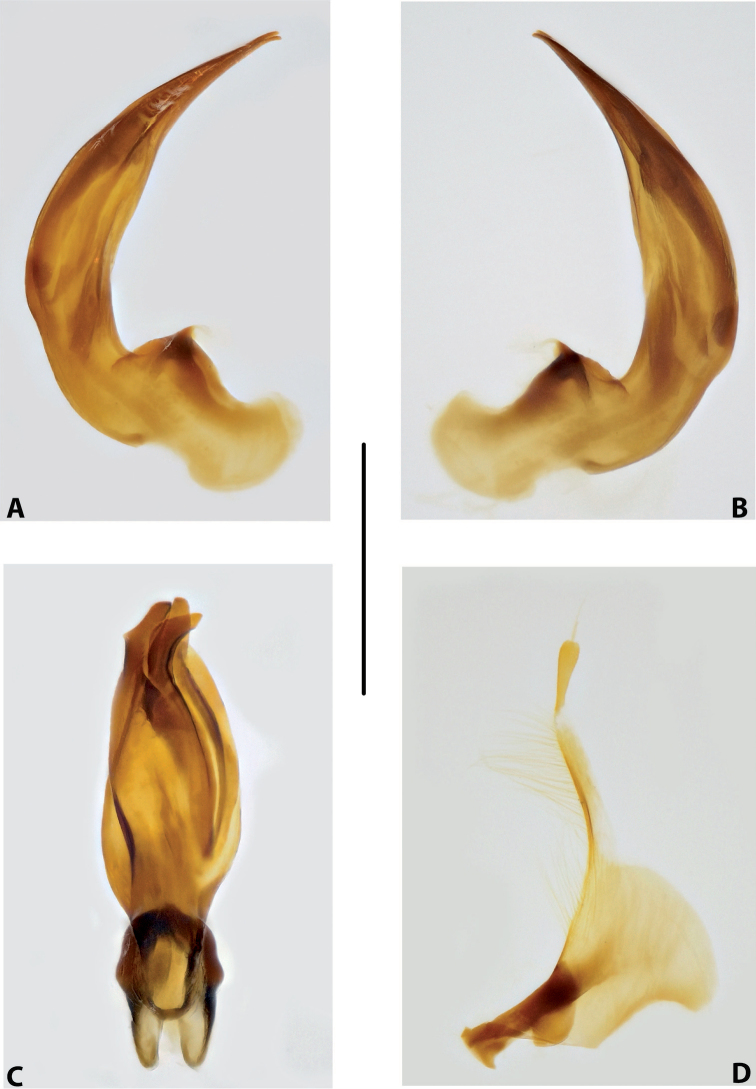
Copelatus
bakewelliA median lobe in lateral view, right side B median lobe in lateral view, left side C median lobe in ventral view D left paramere in external view. Scale bar: 0.5 mm.